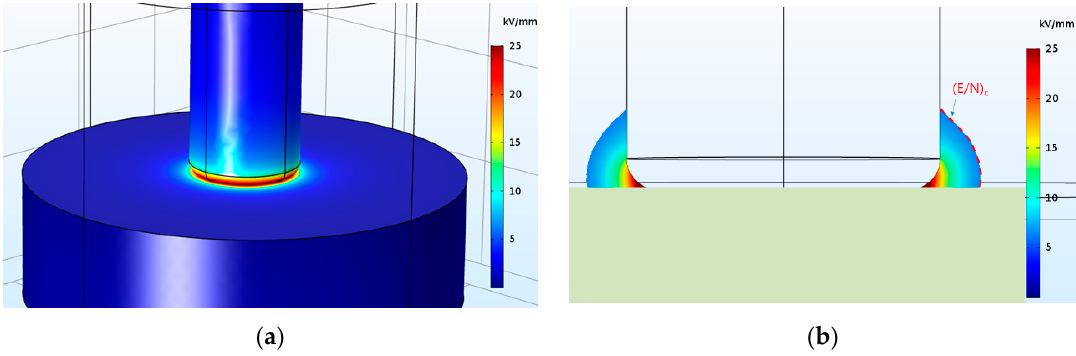
Figure 7. Finite element method electric field result (1000 pC, 15 kV applied). ( a ) electric field distribution, ( b ) high energy region.